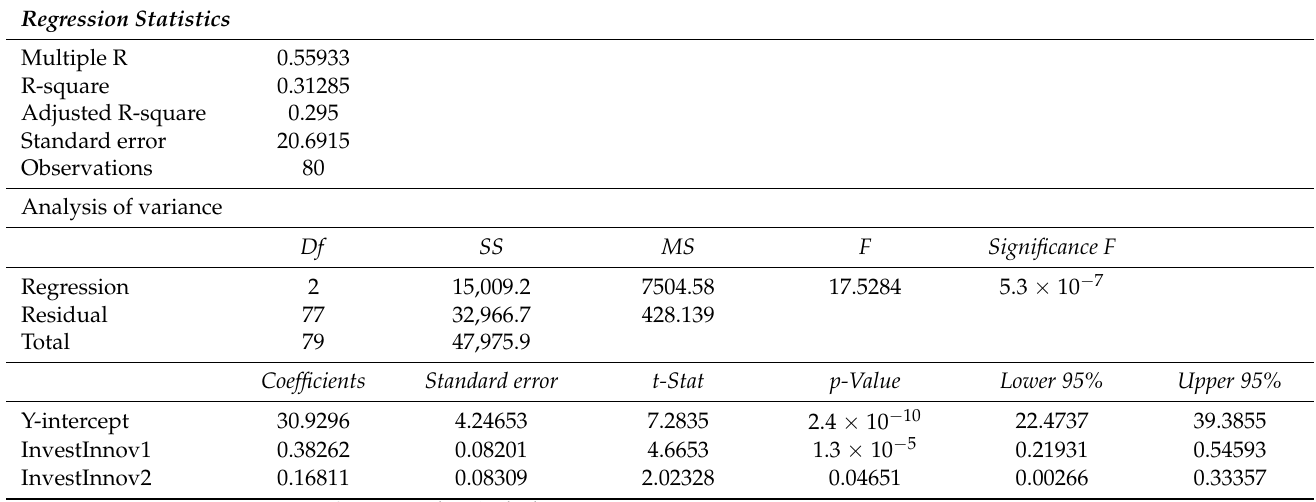
Table A1. Regression statistics of the dependence Srisk 1 on investments in innovation (InvestInnov).